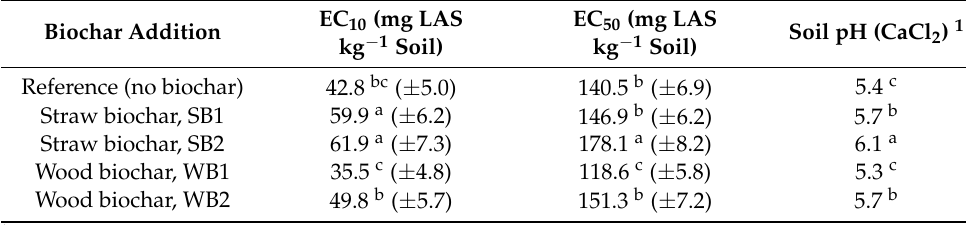
Table 3. Effect concentrations (EC 10 and EC 50 ) for ecotoxicity of linear alkylbenzene sulfonate (LAS) to potential ammonia oxidation (PAO) in agricultural soil with or without biochar (1.1%, wt./wt.). Data are model estimates ± standard error. Assays were performed after 1 week of soil interaction with biochar and LAS. The resulting soil pH(CaCl 2 ) is shown. Letters indicate significant differences between biochar treatments ( p <